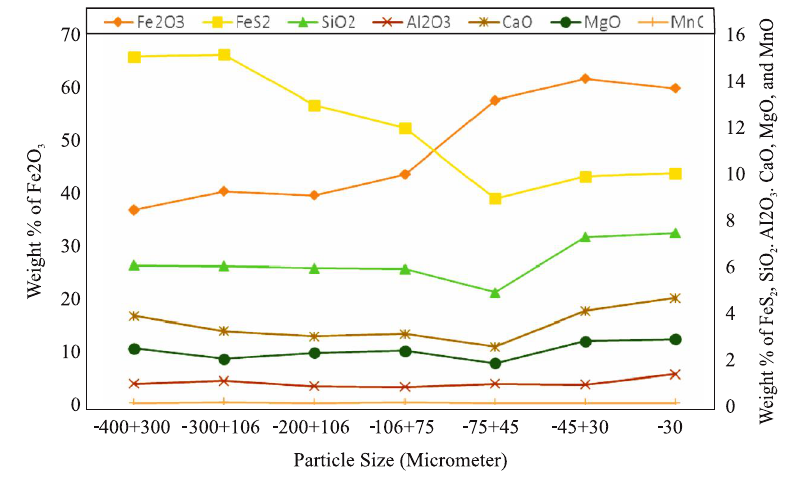
FIG. 2. MINERAL DISTRIBUTION IN VARIOUS PARTICLE SIZES OF ZARD KOH